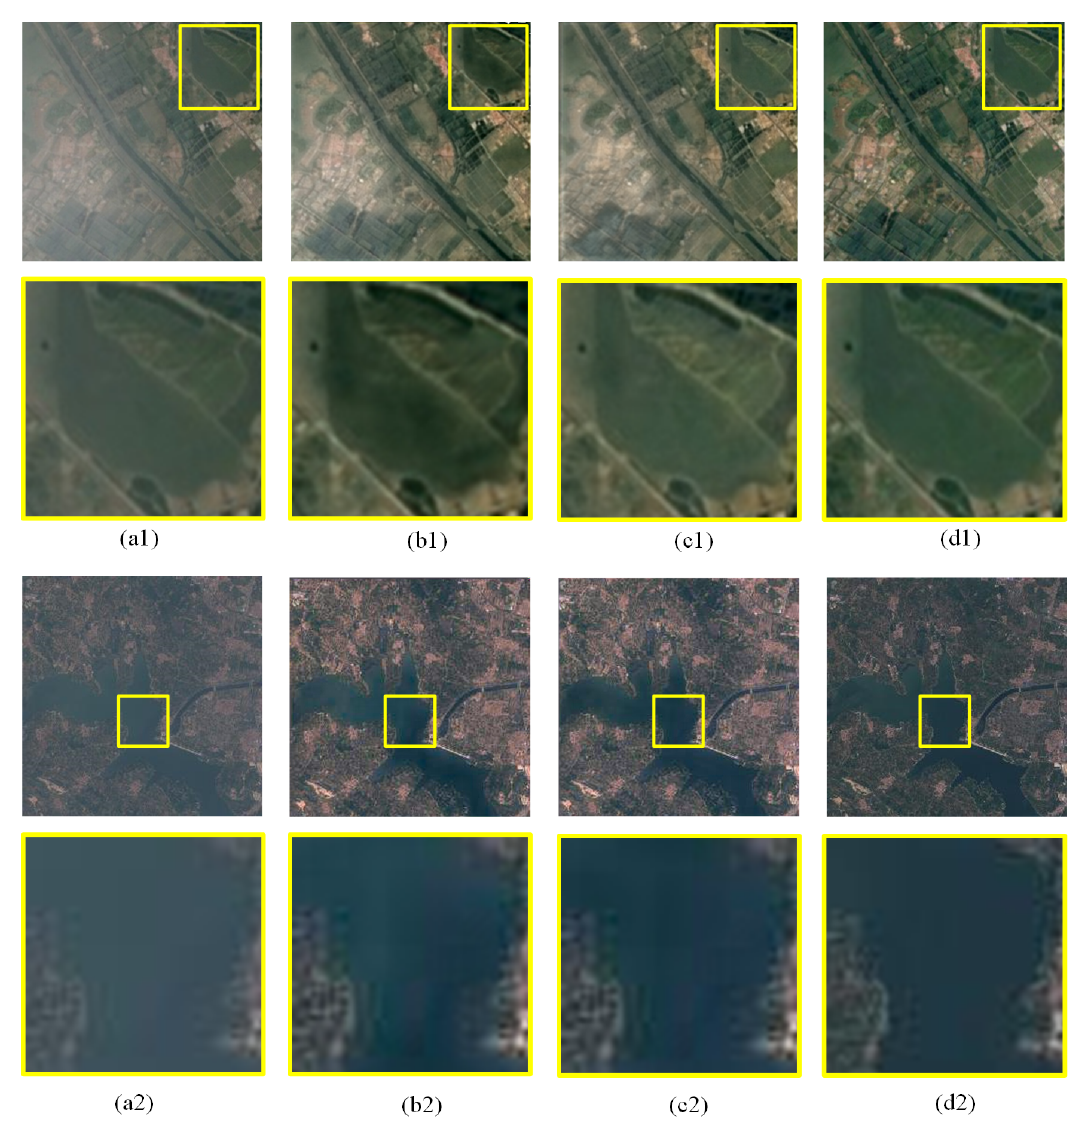
Figure 11. The thin cloud removal results under the influence of adversarial training: ( a1 , a2 ) input cloudy im- age, ( b1 , b2 ) reconstructed images without adversarial training, ( c1 , c2 ) reconstructed images with adversarial training, and ( d1 , d2 ) reference cloud-free